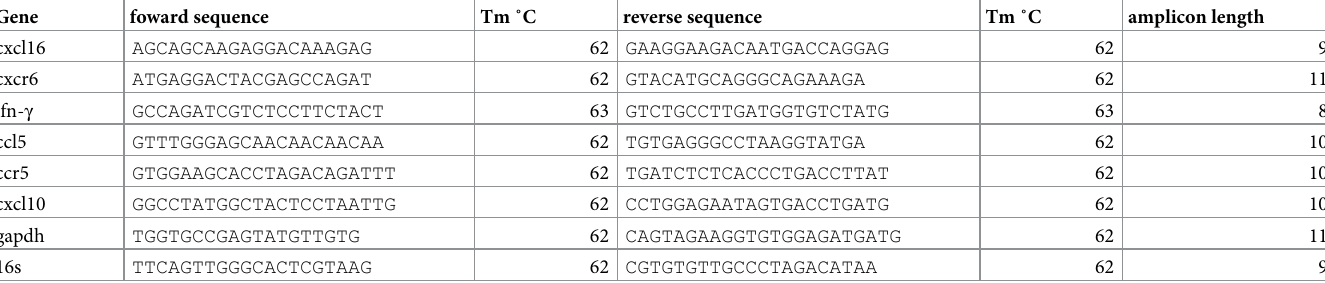
Table 1. Oligonucleotide sequences of specific genes of hamster and ribosomal gene of Leptospira . Gene foward